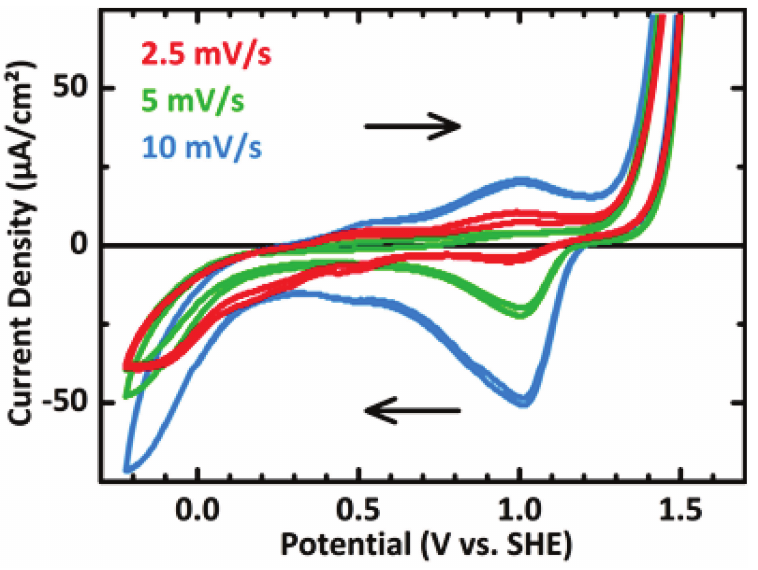
Figure 8. CV curves of a PCMO sample with x above +1.2 V vs. SHE and a reversible redox process centered at +1.0 V vs. SHE (pH